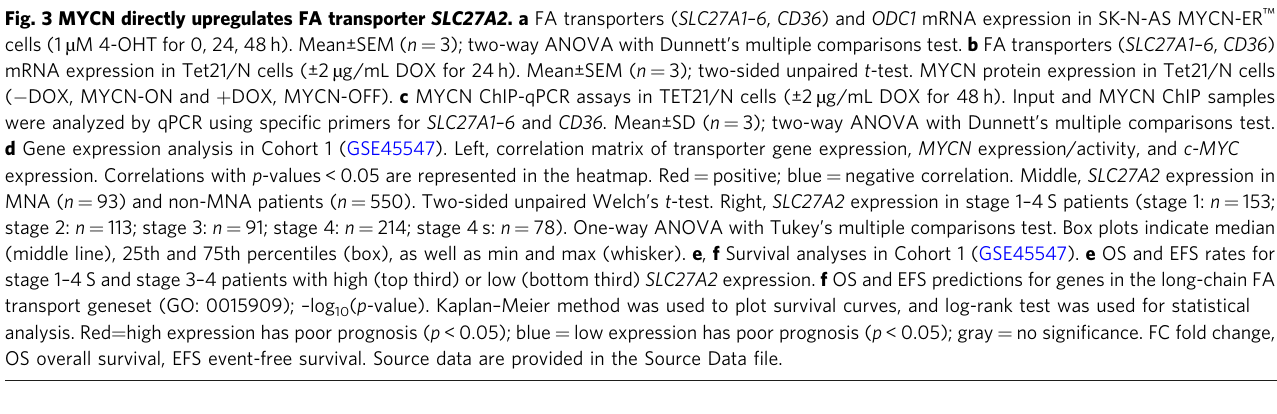
Fig. 3 MYCN directly upregulates FA transporter SLC27A2 . a FA transporters ( SLC27A1 – 6 , CD36 ) and ODC1 mRNA expression in SK-N-AS MYCN-ER ™ cells (1 µ M 4-OHT for 0, 24, 48 h). Mean±SEM ( n = 3); two-way ANOVA with Dunnett ’ s multiple comparisons test. b FA transporters ( SLC27A1 – 6 , CD36 ) mRNA expression in Tet21/N cells (±2 µ g/mL DOX for 24 h). Mean±SEM ( n = 3); two-sided unpaired t -test. MYCN protein expression in Tet21/N cells ( − DOX, MYCN-ON and + DOX, MYCN-OFF). c MYCN ChIP-qPCR assays in TET21/N cells (±2 µ g/mL DOX for 48 h). Input and MYCN ChIP